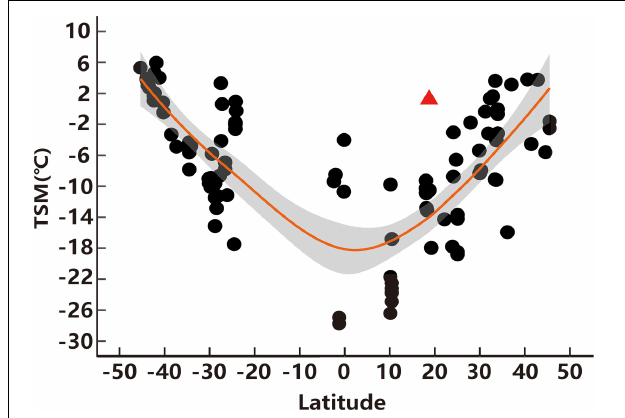
FIGURE 4 | Thermal-safety margins (TSM) of lizards across latitudes. Each spot indicates a TSM of each species and the red triangle represents the TSM of high-elevation T. kuehnei . The orange line represents the fitting curve of TSM along the global latitude and the gray area represents the 95% confidence interval. The database was collected from published analysis (Sunday et al.,